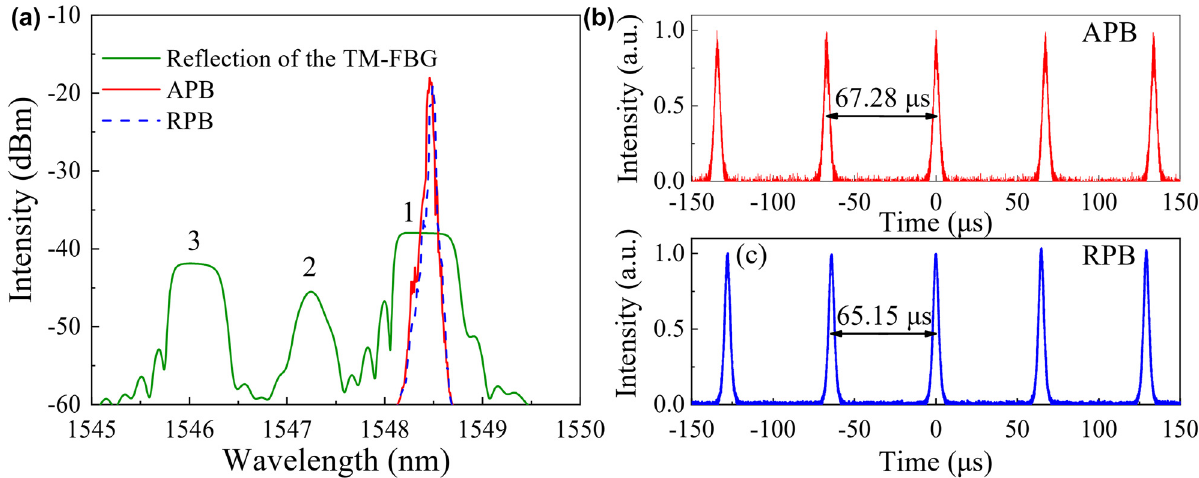
Figure 5: Output characteristics of the laser in spectral and temporal domains. (a) Optical spectra of the Q -switched APB and RPB lasers, and reflection spectrum of the TM-FBG. (b) Typical pulse train of the Q -switched APB laser. (c) Typical pulse train of the Q -switched RPB laser.